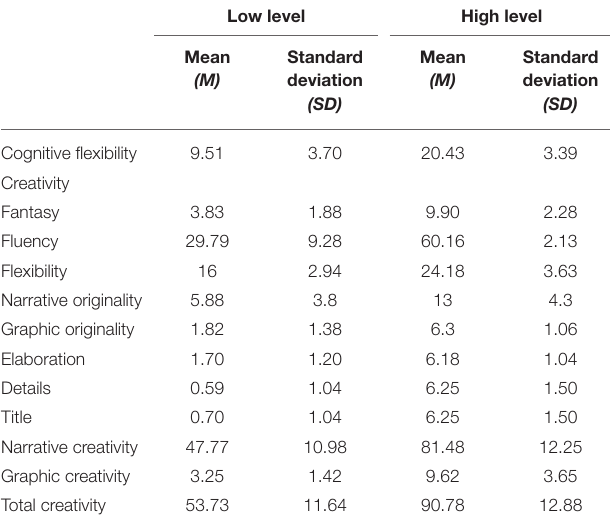
TABLE 2 | Mean (M) and SD of categorized variables by media and plus half